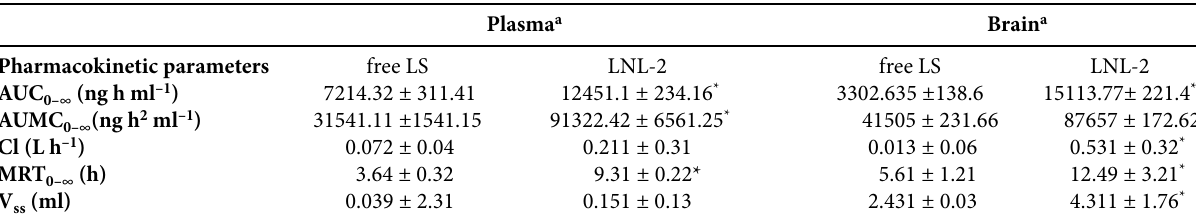
Table 4. Estimation of plasma and brain pharmacokinetic parameters of lomustine (LS) after intravenous bolus administration of free lomustine (LS) and lomustine loaded lipid nanostructures (LNL-2)